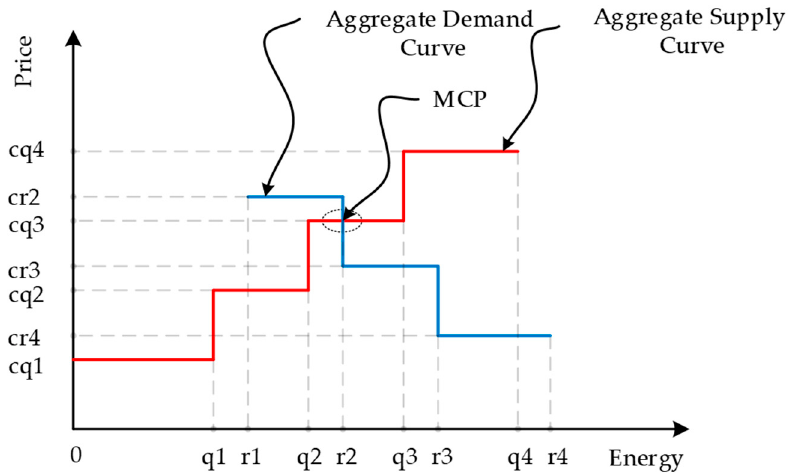
Figure 1. Piecewise traditional supply-demand curve with supply blocks labeled ‘q’, demand blocks labeled ‘r’, and prices labeled ‘cr’ and ‘cq’. Demand curve is shifted due to LA’s base load block (r1).